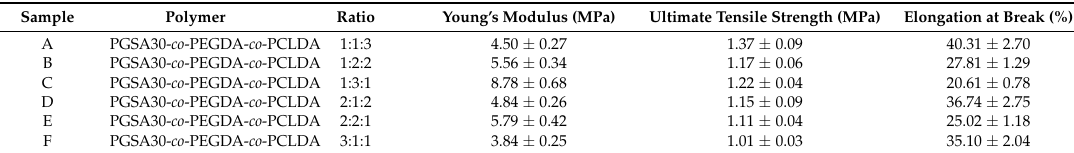
Table 5. Mechanical properties of UV-cured PGSA15- co -PEGDA- co -PCLDA in various weight ratio ( n ≥ 3).